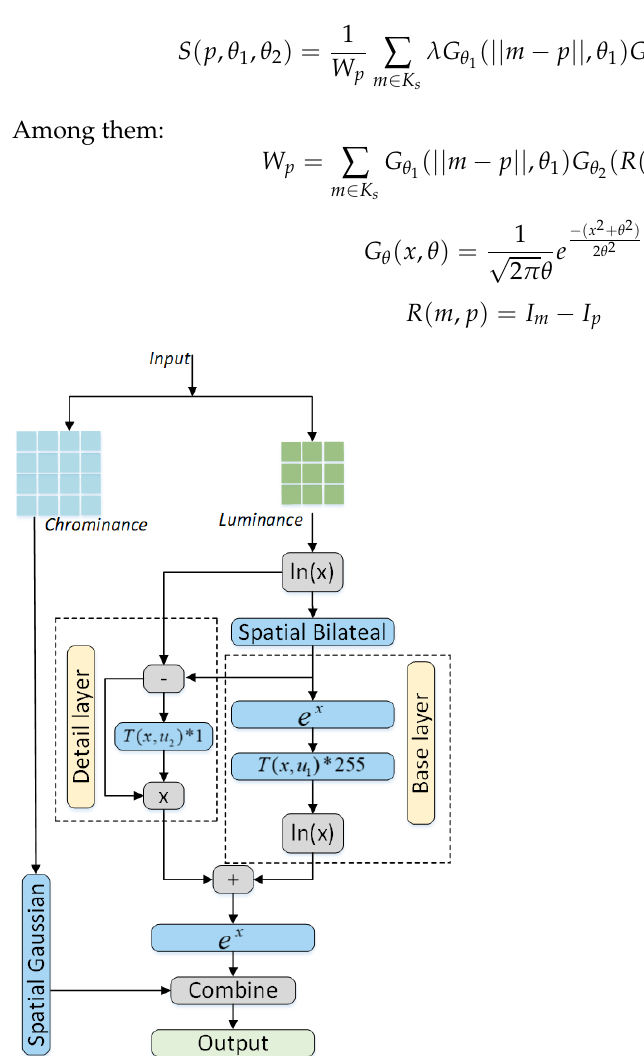
Figure 3. Details of the tone mapping